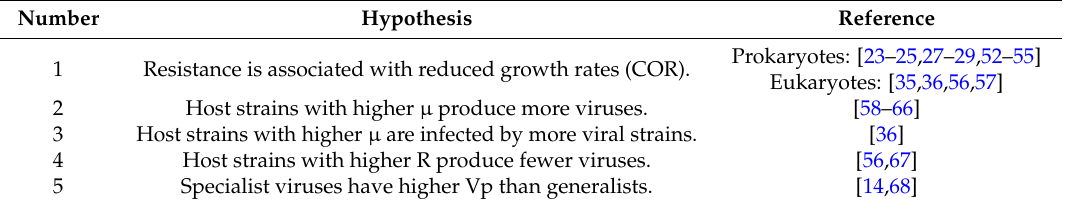
Table 1. Hypotheses tested in the current study based on outcome of previous virus-host interaction studies. µ : growth rate; R: resistance; Vp: viral